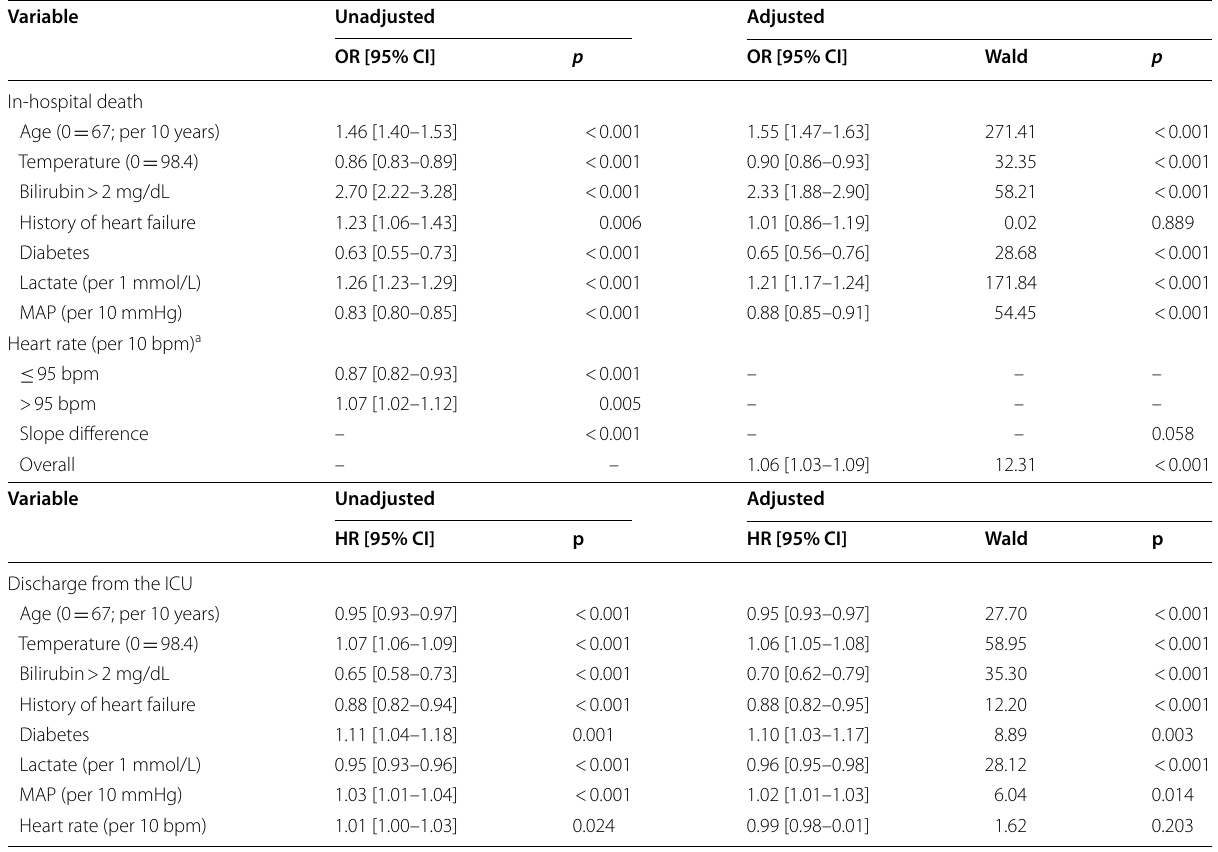
Table 3 Results for in-hospital death and time-to-ICU